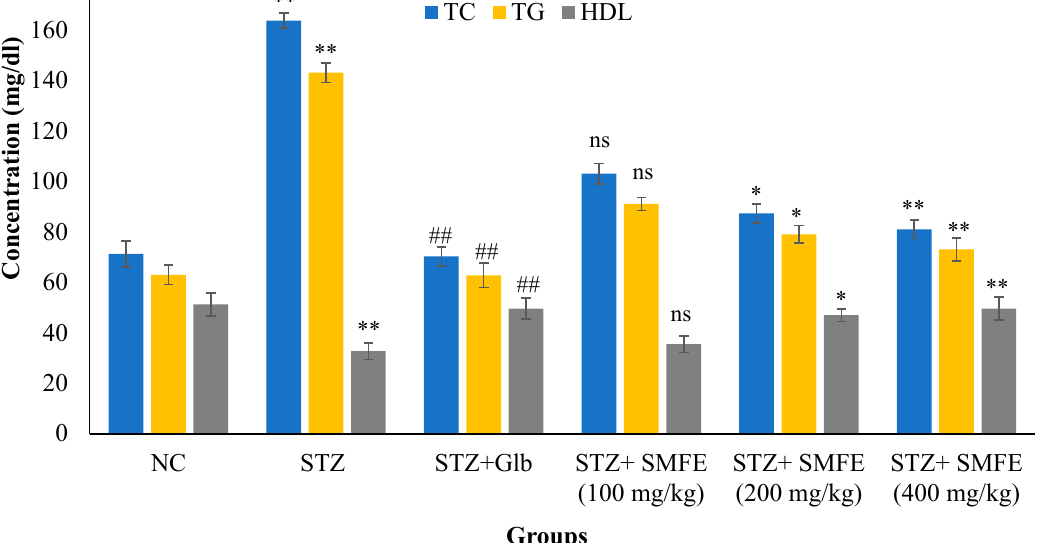
Figure 8. Effects of SMF extract on lipid parameters in mice after 28 days of therapy. Data are represented as the mean ± SEM ( 𝑛 = 6). Group I = normal control, Group II = toxic control, Group III = positive control, Group IV = ethanol extract 100 mg/kg, Group V = ethanol extract 200 mg/kg, Group VI = ethanol extract 400 mg/kg, ** p < 0.01 = significant when compared with the diabetic control group. * p < 0.05 and ## p < 0.01 = significant when compared with diabetic control. ns p > 0.05 = non-significant when compared with diabetic control. NC = normal control; STZ = streptozotocin; SMFE = S. mangifera fruit extract; Glb = glibenclamide.